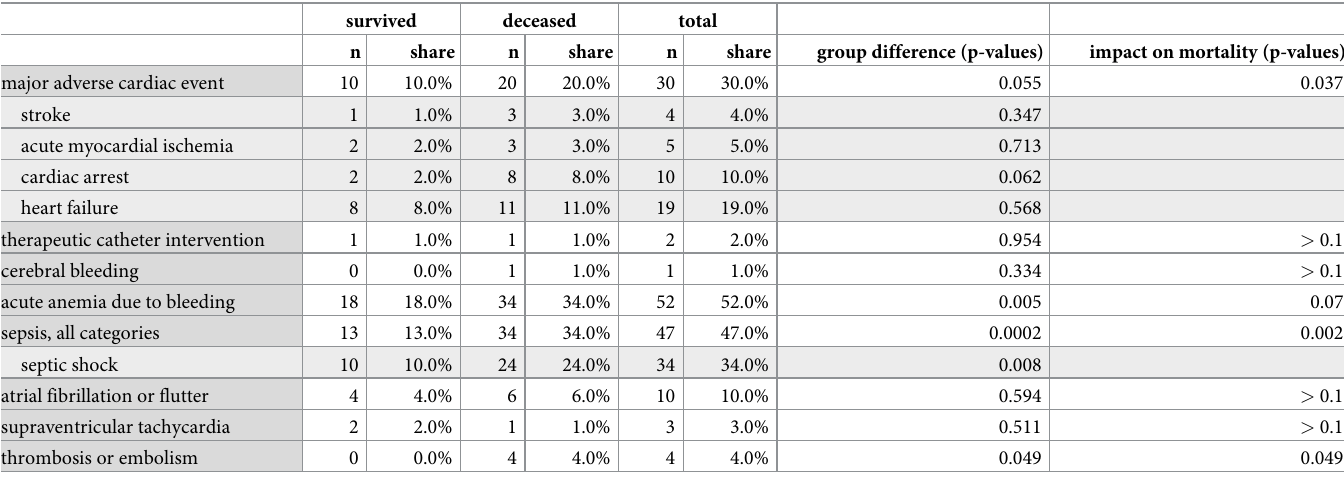
Table 3. In-hospital complications.